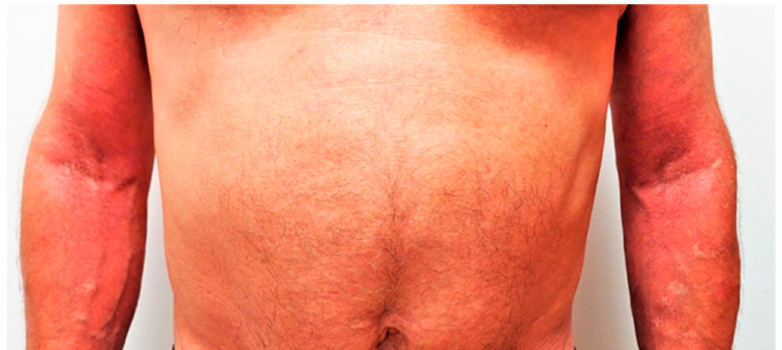
Figure 4. Patient 4 months after the initiation of dupilumab with EASI score of